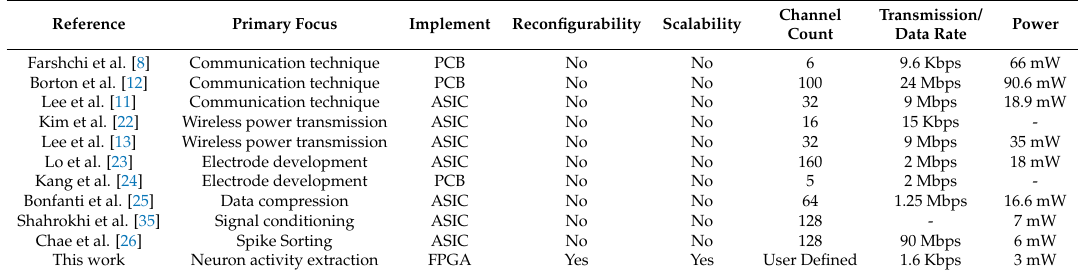
Table 2. Comparison with previous